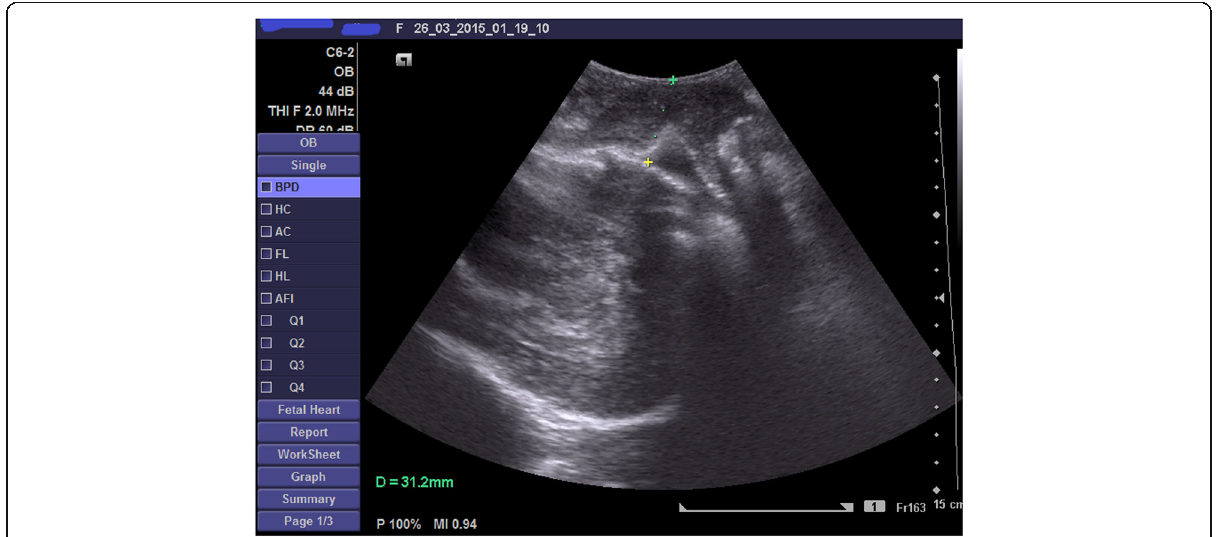
Fig. 2 TPUS showing a FHPD of 3.1 cm. The probe was put longitudinally on the perineum; the probe was manipulated to obtain the shortest distance. The soft tissue was compressed firmly but gently without causing pain. The shortest distance from the perineal skin surface to the